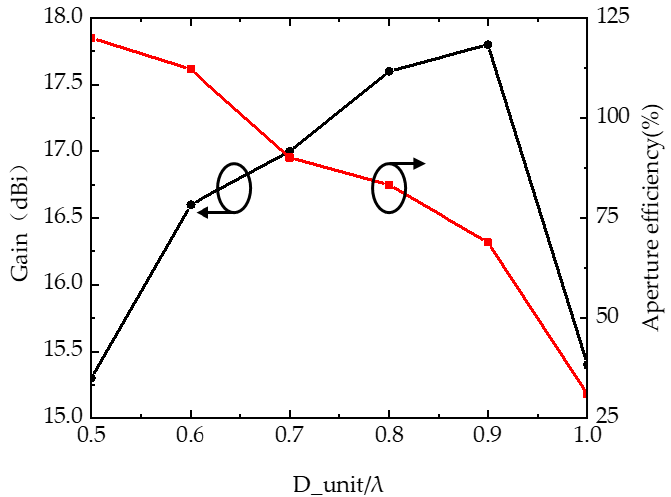
Figure 6. The simulated gain and aperture efficiency of the proposed array with different element spacing Black: Gain, Red: Aperture efficiency.